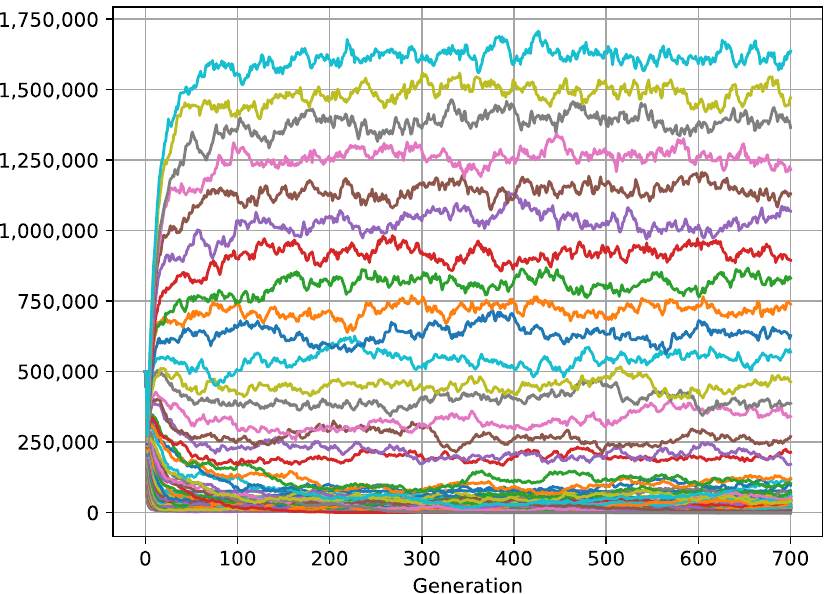
Figure 7. Data obtained from 2Plank2.json in Supplementary Material. A total of 100 species with aggregated distribution compete in a habitat of 20,000 cells. Each species is represented by a color. After 700 generations, 92 species still coexist in stable evolutionary equilibrium, while only 55 species managed to coexist under the same conditions and in the same generation but with 12,650 cells (see simulation 1 of 2Plank2.json in Supplementary Material). More fragmentation increases the probability of ending up in cells where a few competent organisms concur.